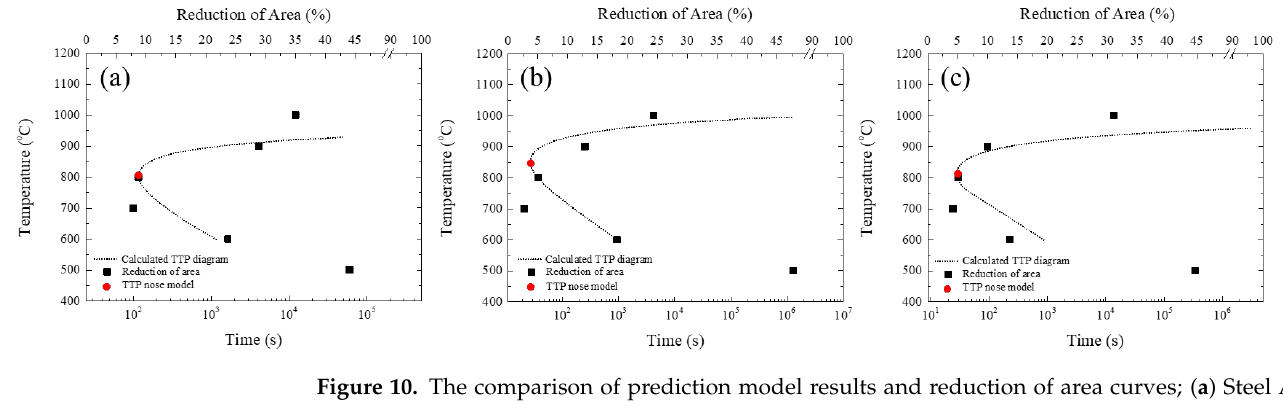
Table 2. Chemical composition (wt.%) of high-Mn steels from reference data.